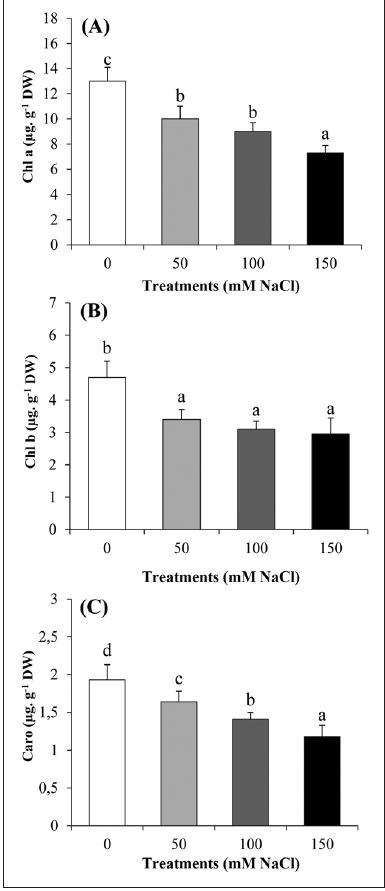
Fig. 2: Photosynthetic pigments in C. officinalis after four weeks of salt treatments. (A) Chlorophyll a (Chl a), (B) chlorophyll b (Chl b), and (C) total carotenoids (Caro). Means with SD (n = 10). Different low- ercase letters above the bars indicate significant differences between NaCl treatments according to the Tukey test (α =